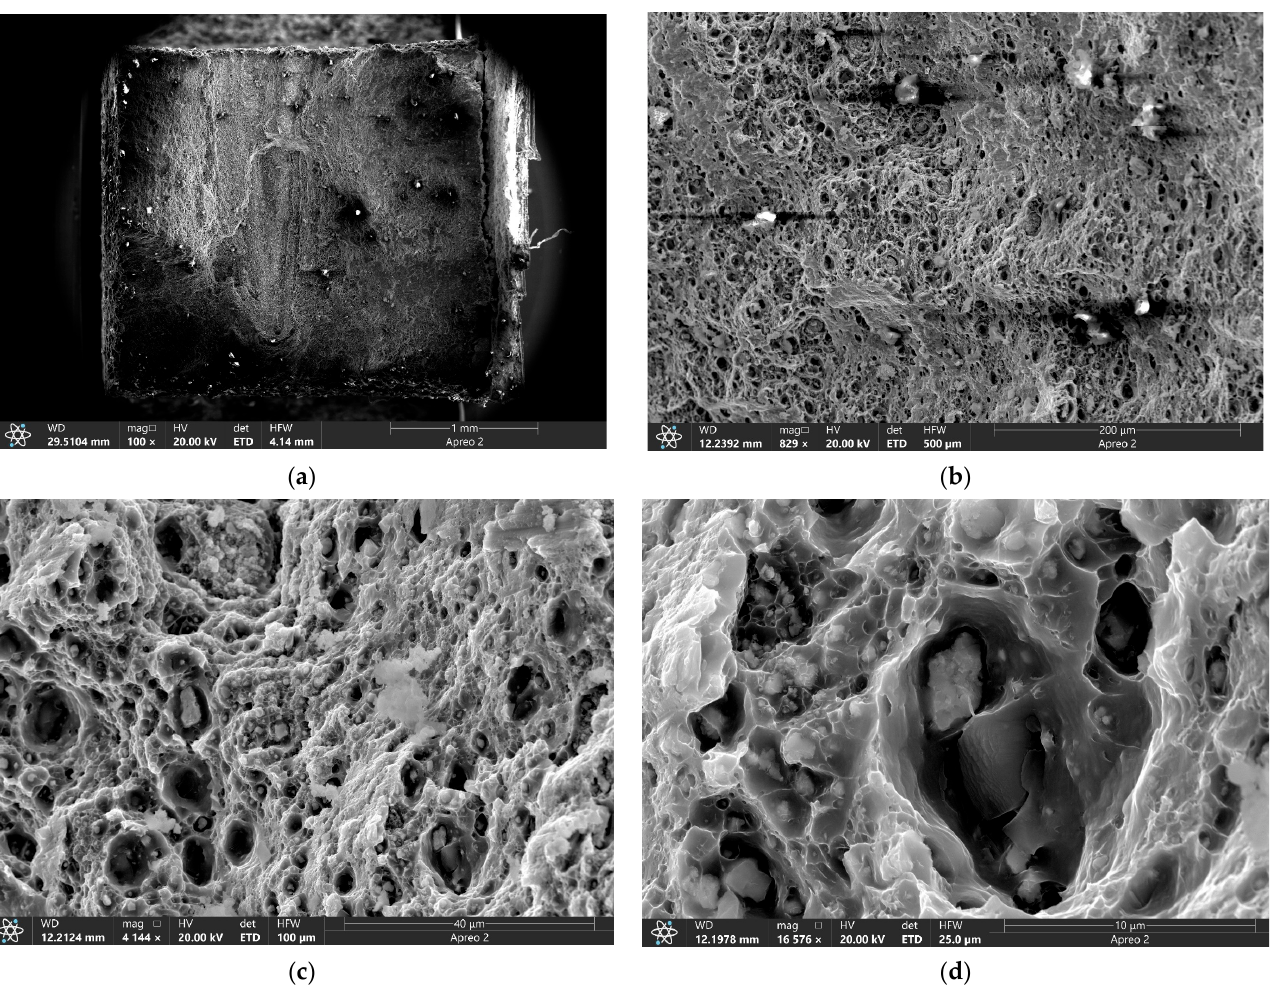
Figure 18. SEM BSE images of the tensile test fracture surfaces of the FSP-ed RPPs/AA5056 composite after 4 passes ( a – d ).